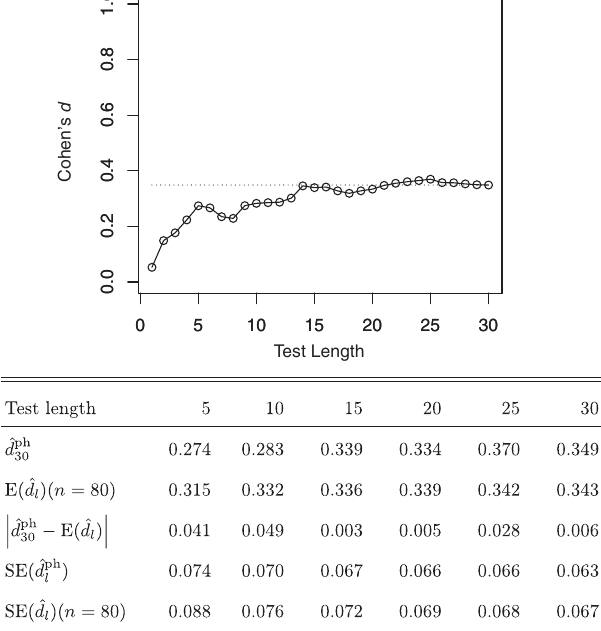
FIG. 8. Cohen ’ s d as a function of test length of the FCI- CAT, as calculated by post hoc simulation (sample size ¼ 78 respondents). The dotted line shows d ¼ 0 . 35 , which is the value of Cohen ’ s d at a test length of 30. The values in the table are characteristic points plotted in the graph and associated values calculated from the Monte Carlo simulation (see description